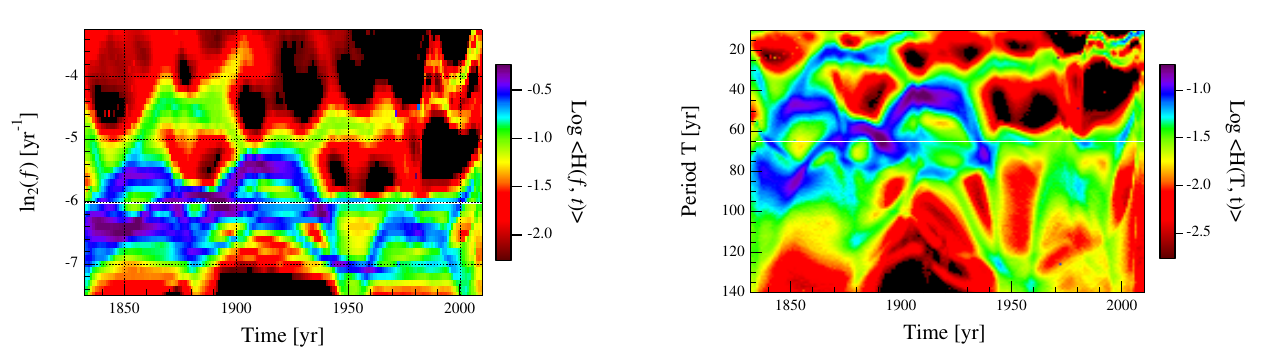
Fig. 5. Ensemble averaged Hilbert Spectrum h H ( f,t ) i plotted in the time-frequency plane. Frequency resolu- tion is 0.1 in the ln 2 ( f ) . The horizontal white line indicates the 65 yr characteristic periodicity.